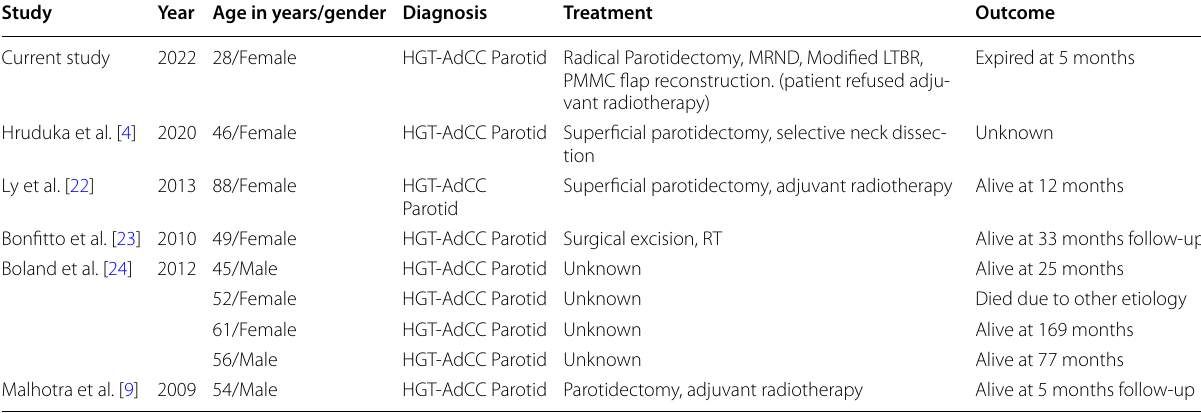
Table 2 Features of patients of HGT-AdCC of parotid gland